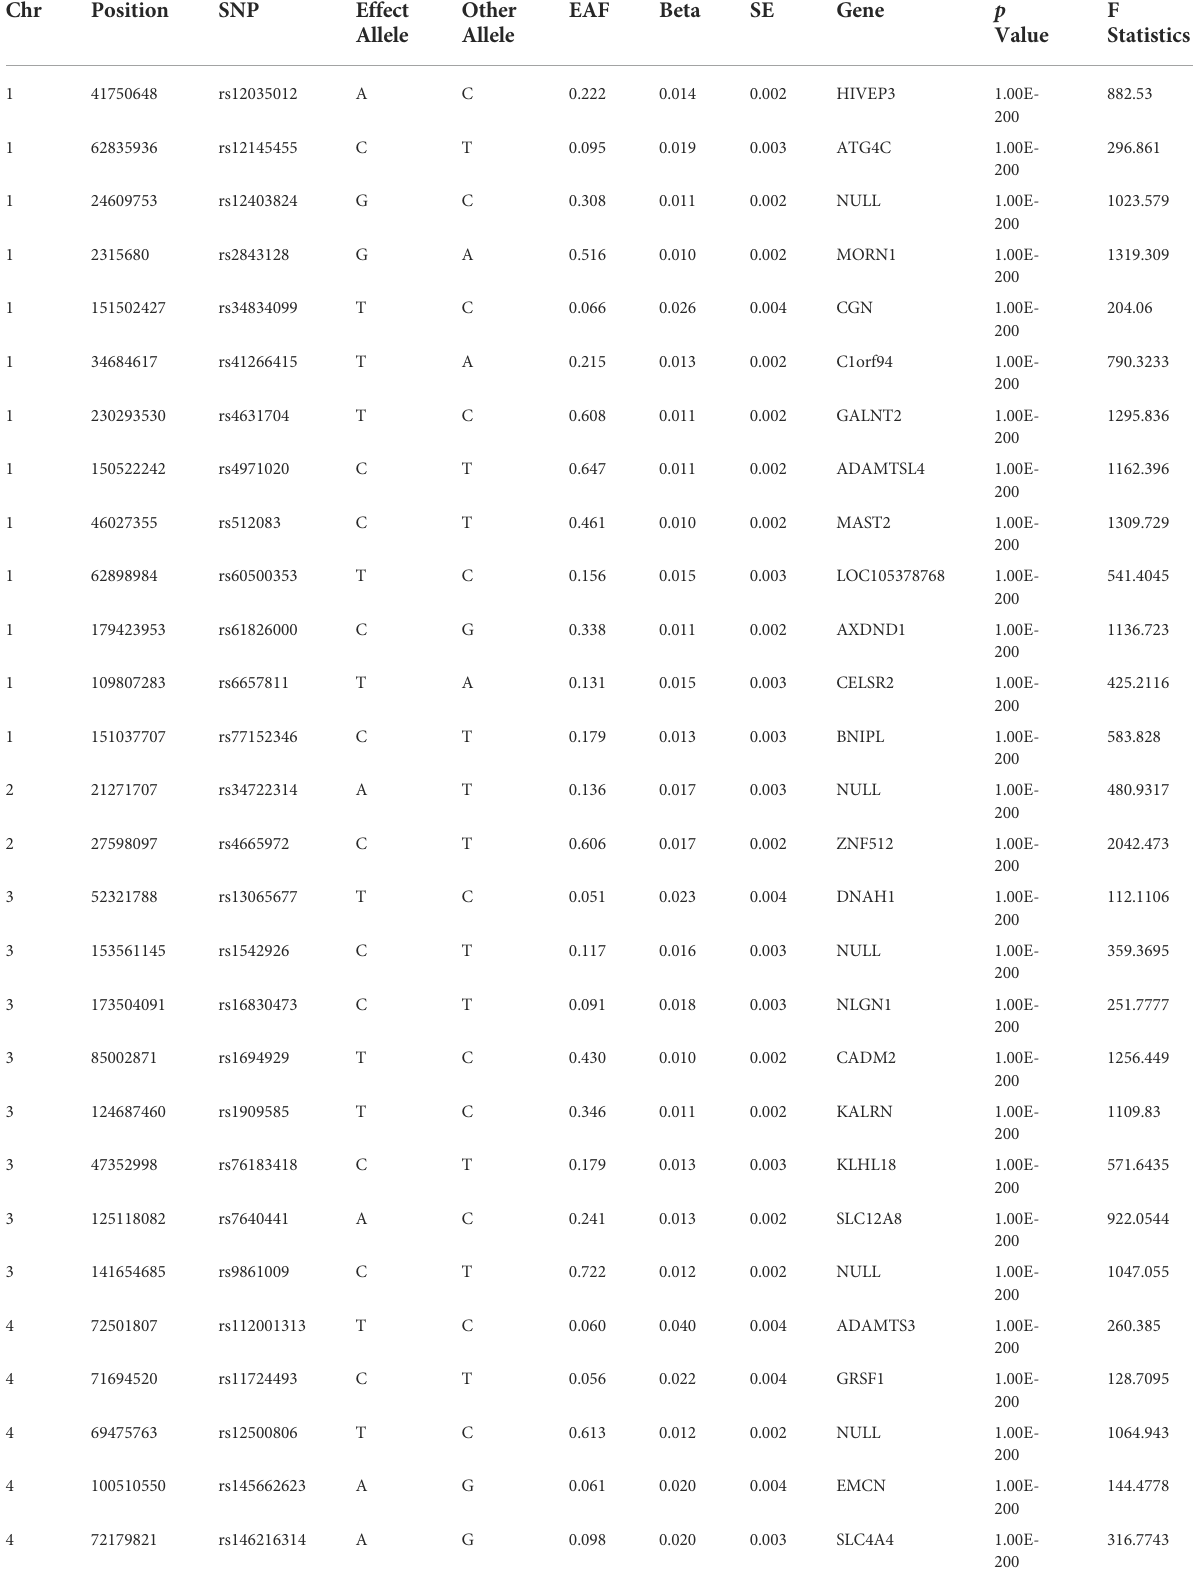
TABLE 1 Vitamin D SNPs used to construct the instrument